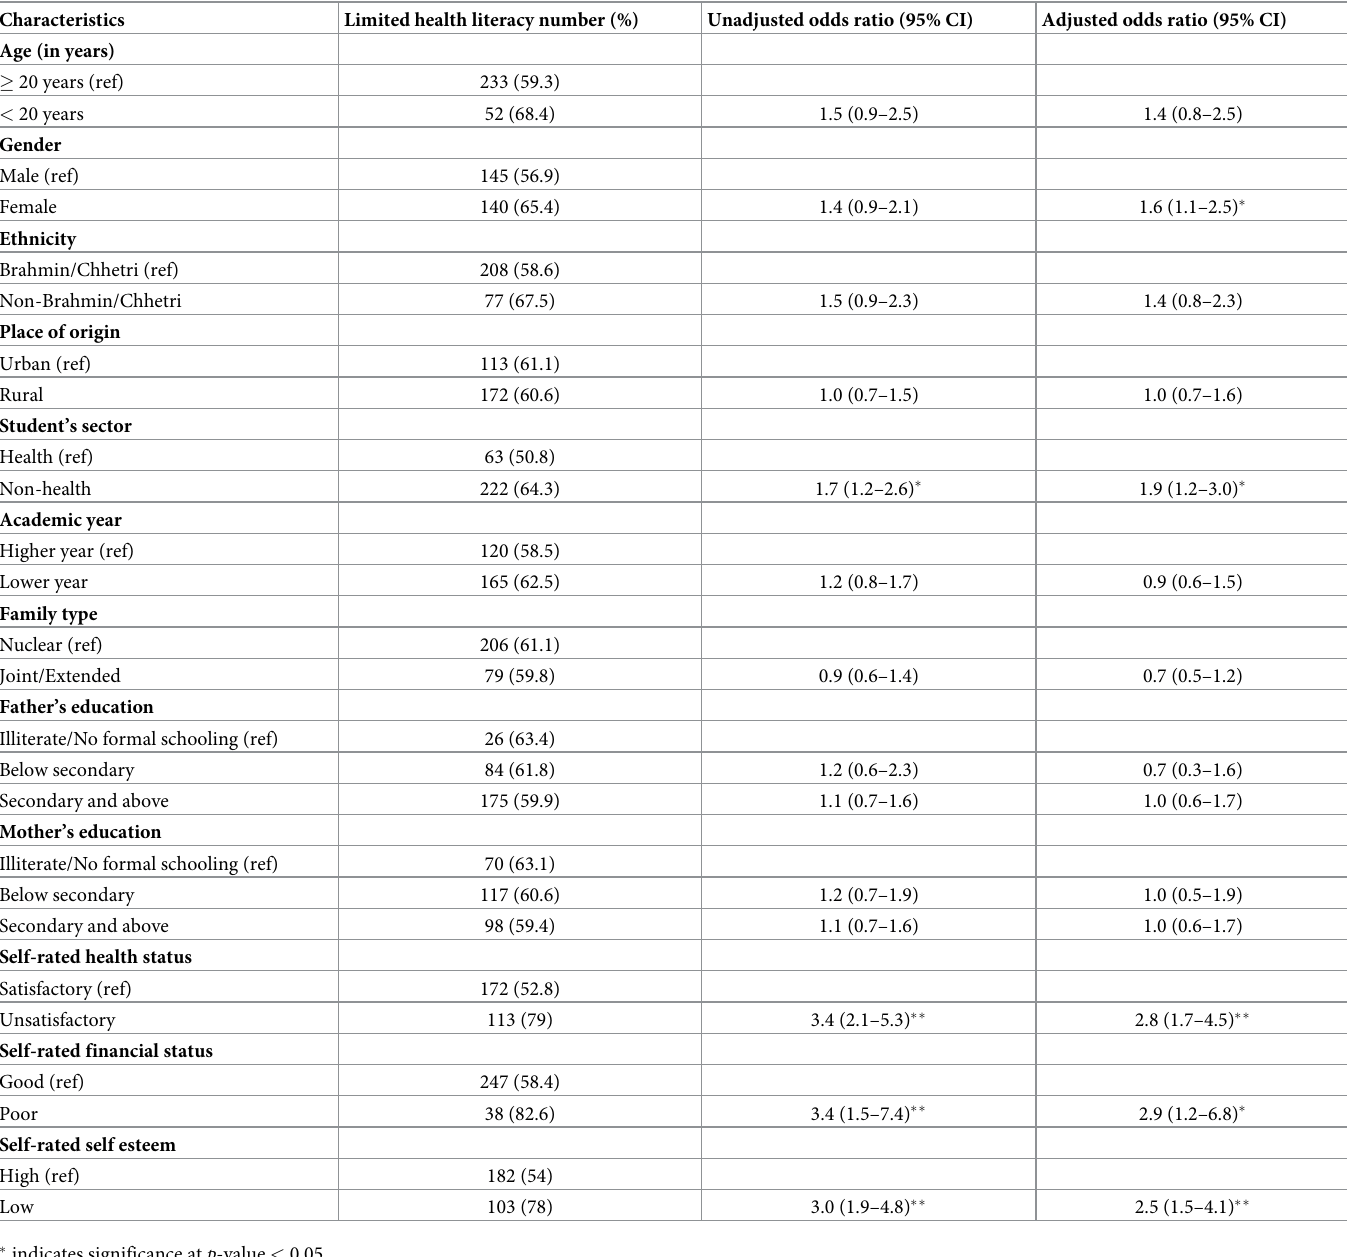
Table 3. Factors associated with limited health literacy (n = 469).